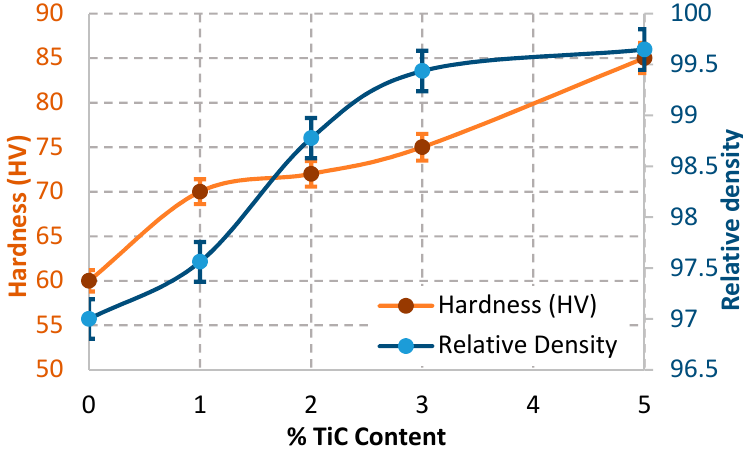
Figure 12. Relative density and Vickers hardness of the Al/TiC nanocomposites with different TiC contents.